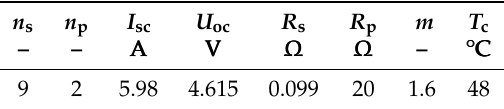
Table 1. Parameters for the example calculation of the photovoltaic current using Equation (10). The number of serial n s and parallel n p connected photovoltaic cells, the short-circuit current I sc , the open-cell voltage U oc , the serial R s and parallel resistance R p , and the non-ideality factor m are setup-specific data. A constant cell temperature T c is assumed